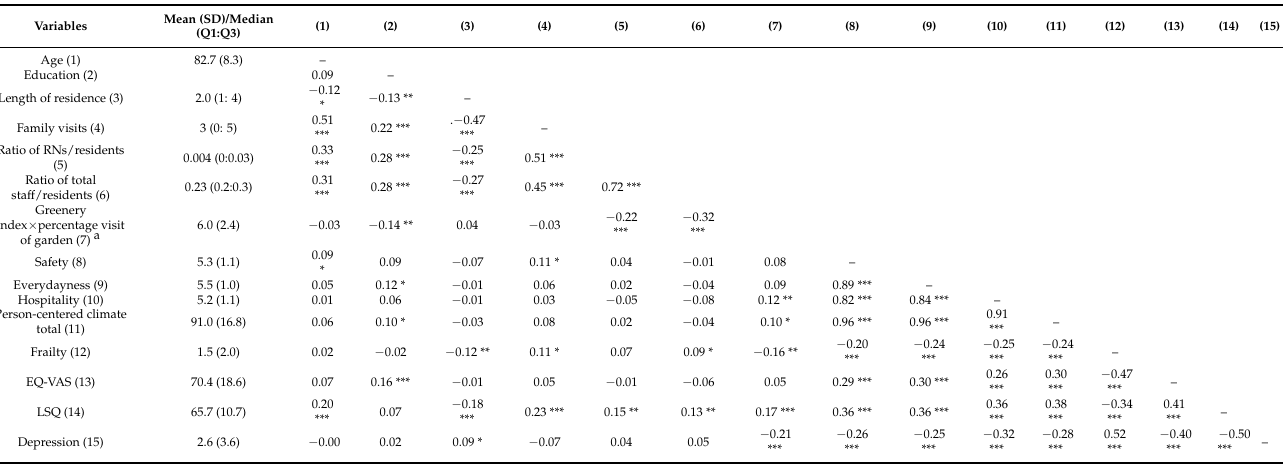
Table 3. Relationships between study